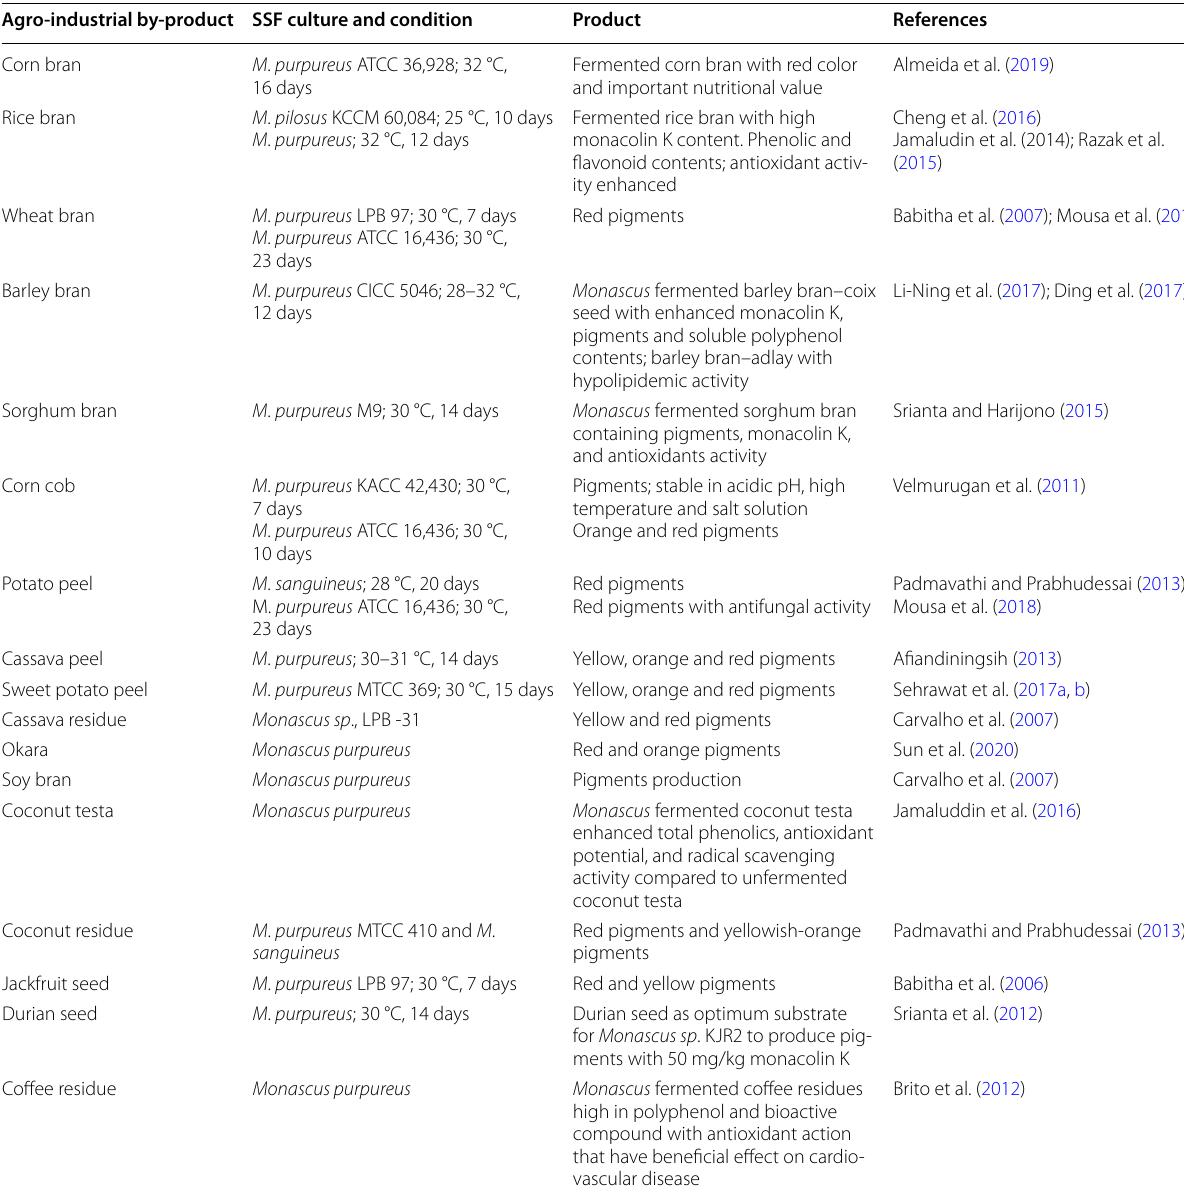
Table 2 Summary of Monascus SSF process on agro‑industrial by‑product substrate Agro-industrial by-product SSF culture and